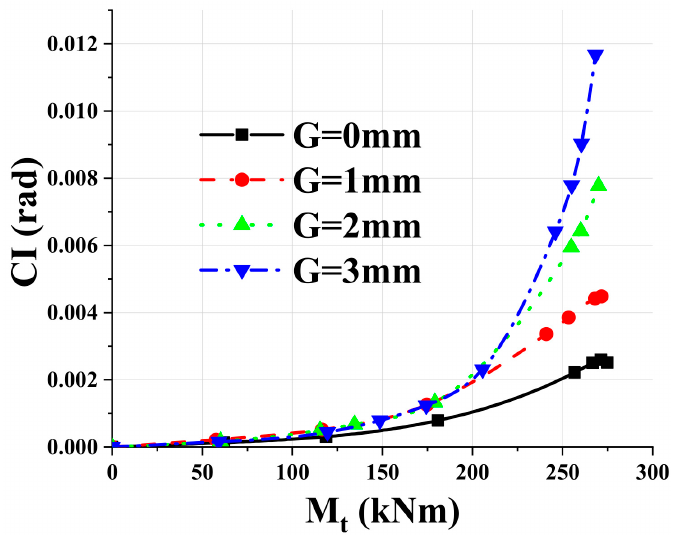
Figure 23. Continuity index-moment curves of connections with different construction